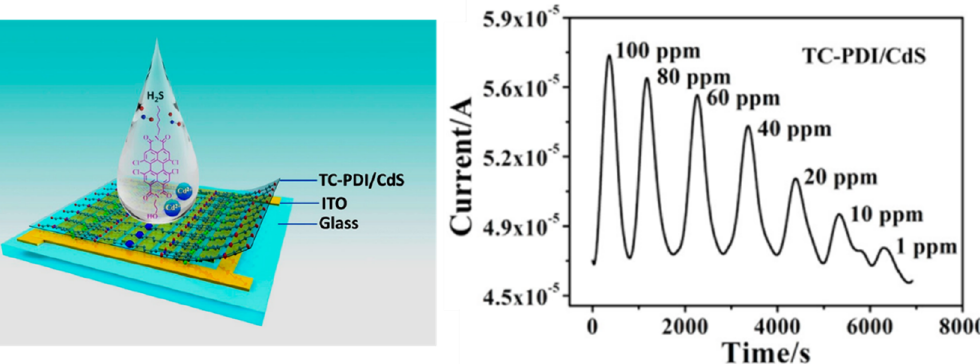
Figure 15. ( a ) Schematic diagram of TC-PDI/CdS (cadmium sulphide) heterojunction. ( b ) Response–recovery curves of TC-PDI/CdS sensor to different trimethylamine (TMA) concentrations. Adapted with permission